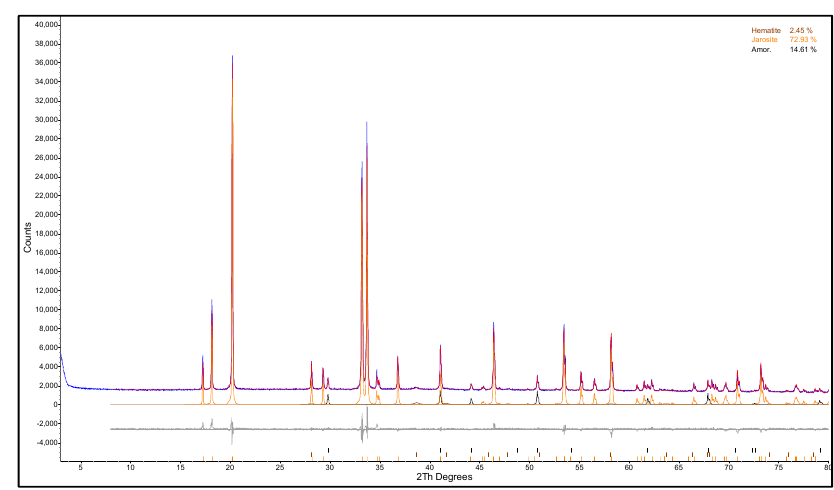
Figure A4. Rietveld refinement plot of sample containing hematite (blue line—observed intensity at each step; red line—calculated pattern; solid grey line, below, difference between observed and calculated intensities; green line corundum standard added for quantification; vertical bars, positions of all Bragg reflections).